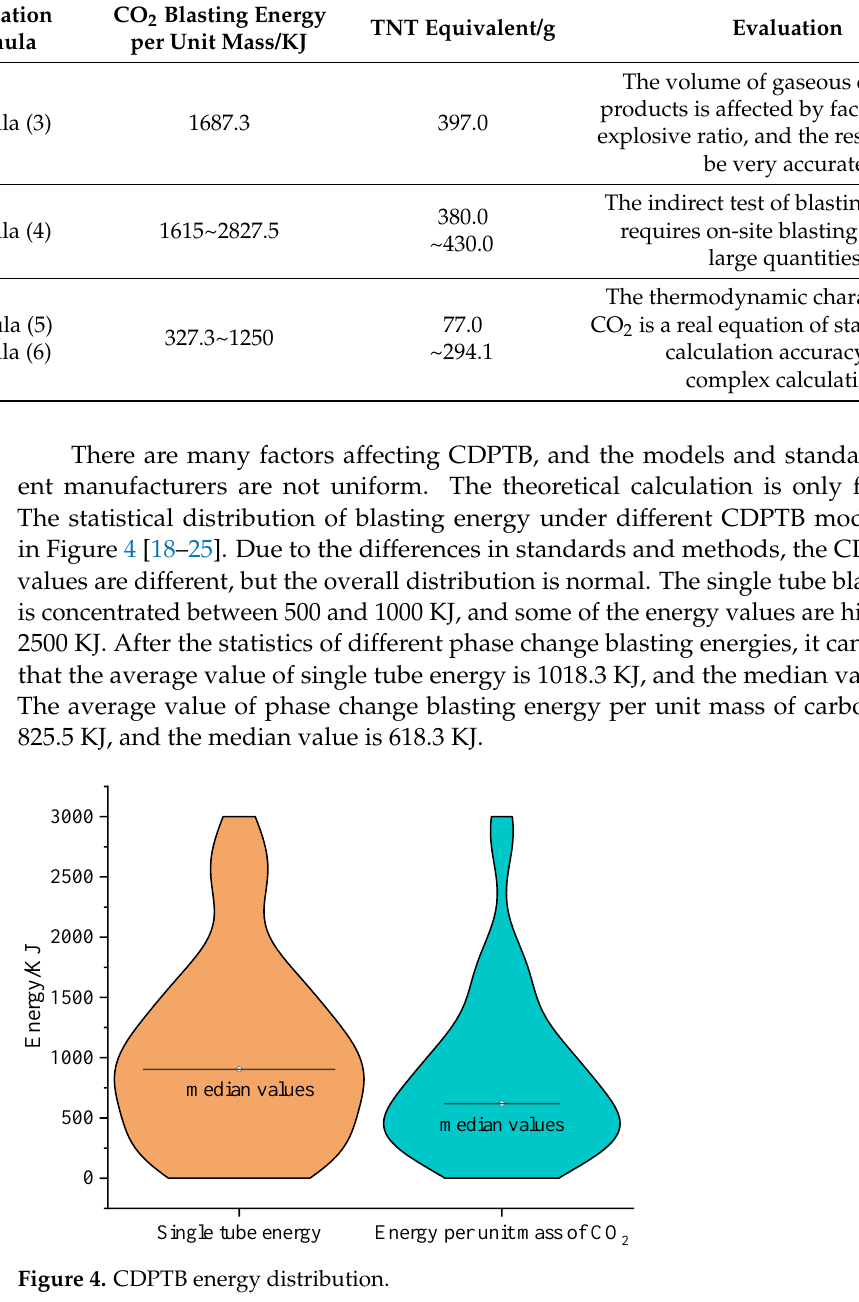
Figure 4. CDPTB energy distribution.